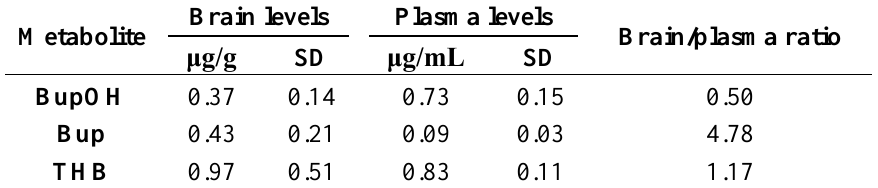
Table 5. The brain/plasma ratio of bupropion and metabolites in the guinea-pig 20 min post dose of 40 mg/Kg bupropion via oral gavage ( n = 5).